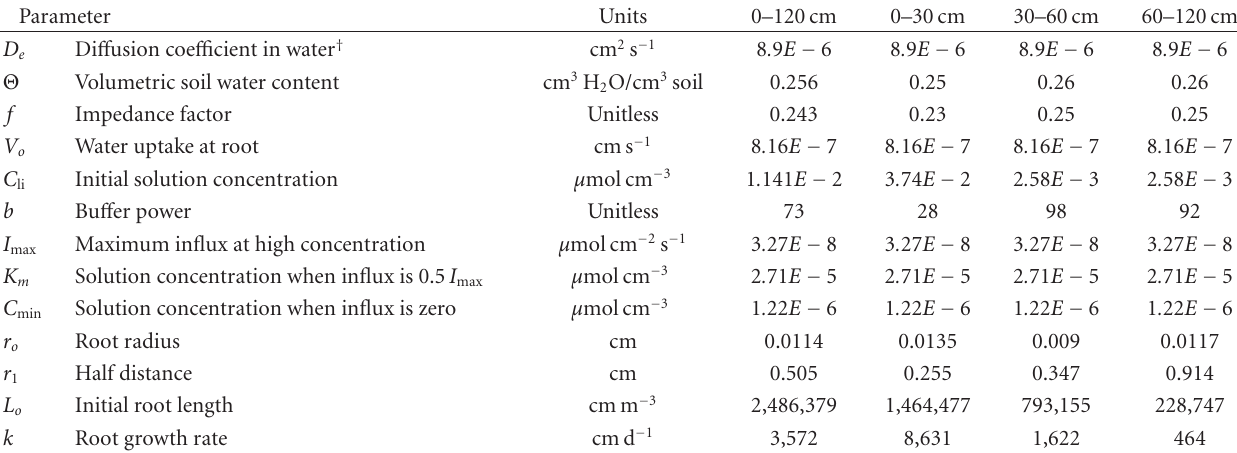
Table 3: Transport, sorption, and root parameters used in the NST 3.0 model to describe P uptake by smooth brome for the 0–120, 0–30, 30–60, and 60–120 cm soil